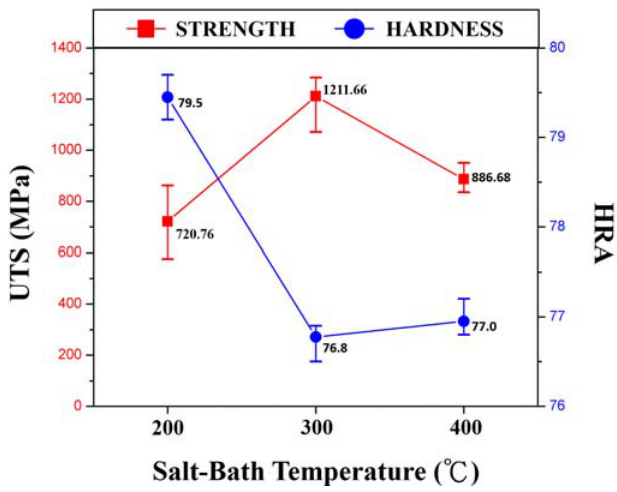
Figure 8. The mechanical properties of the austempered specimens (1080 °C ‐ 30 min) with a salt ‐ bath time of 120 min and different salt ‐ bath temperatures.